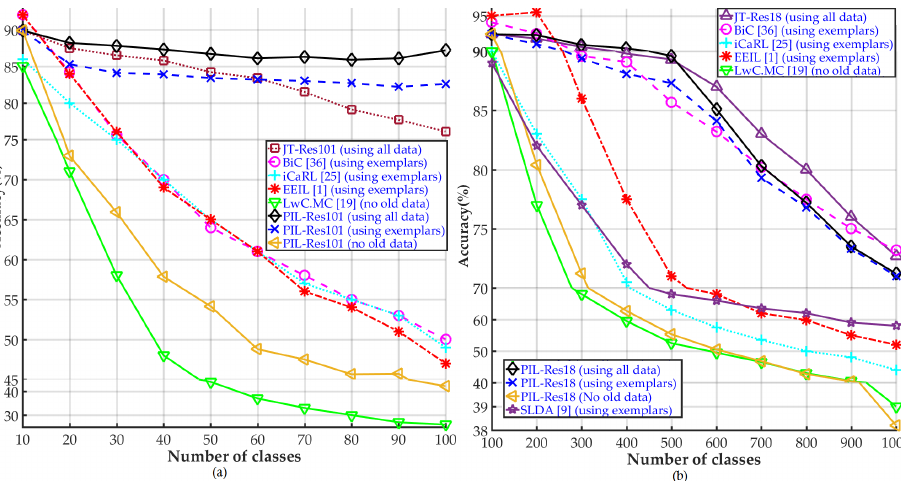
Figure 5. Comparison of the proposed PIL method with the state-of-the-art incremental learning methods on ( a ) CIFAR-100 and ( b ) ImageNet-1000